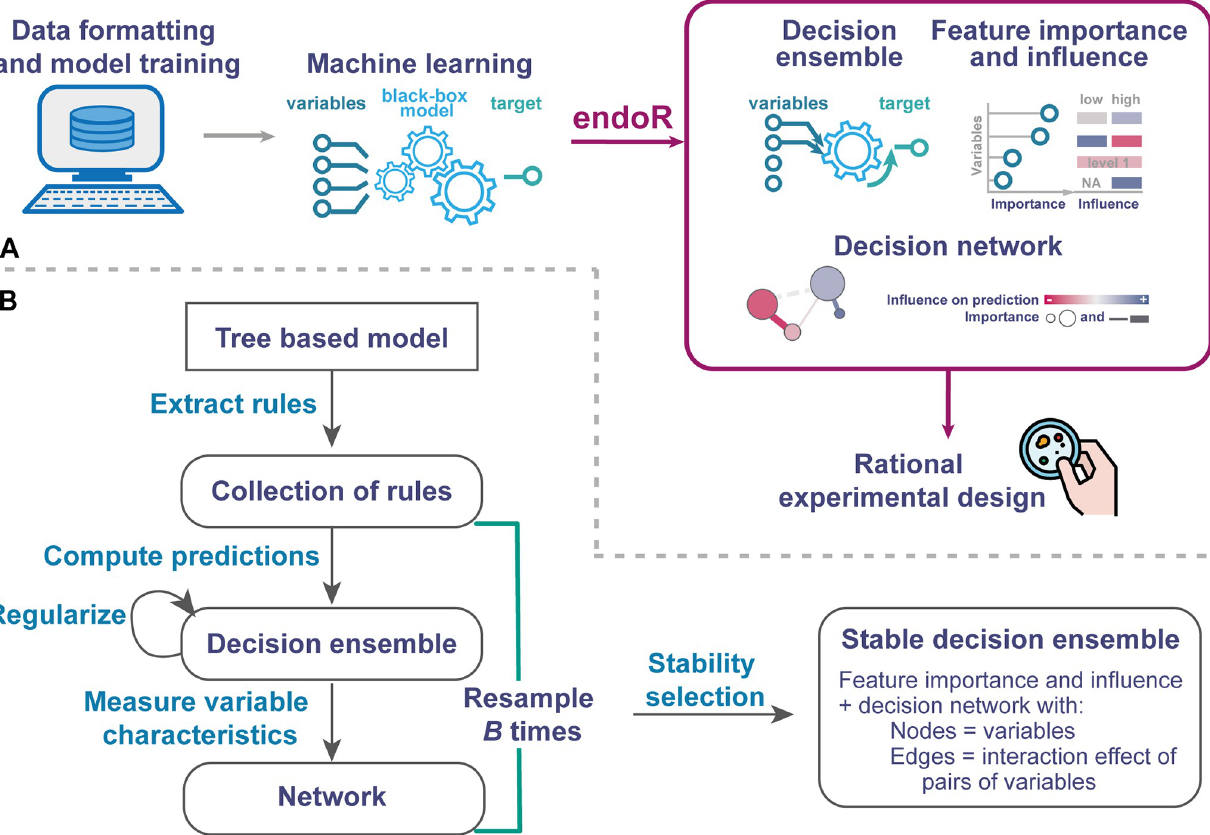
Fig 1. Description of the endoR method workflow. A: General overview of the workflow from data acquisition to the visualization of a network. endoR is applied to a trained classification or regression tree ensemble model. The model is first simplified into a decision ensemble, which is used to calculate the feature importance and influence on predictions. The resultant metrics are displayed in a summary plot listing the feature importance and influence, and as a decision network. The decision network illustrates the association between the response and single or pairs of variables, in regards to feature importance and influence. If the influence of a variable depends on other variables, it will be visible in the network via edges between these nodes. B: Steps taken by endoR to generate a stable network. endoR accepts tree ensemble models that were made with the XGBoost, gbm, randomForest or ranger R-packages [43– 46]. Regularization is optional and consists of simplifying decisions and the decision ensemble to reduce noise. The procedure can be repeated on B bootstraps to select stable decisions prior to constructing the final network.